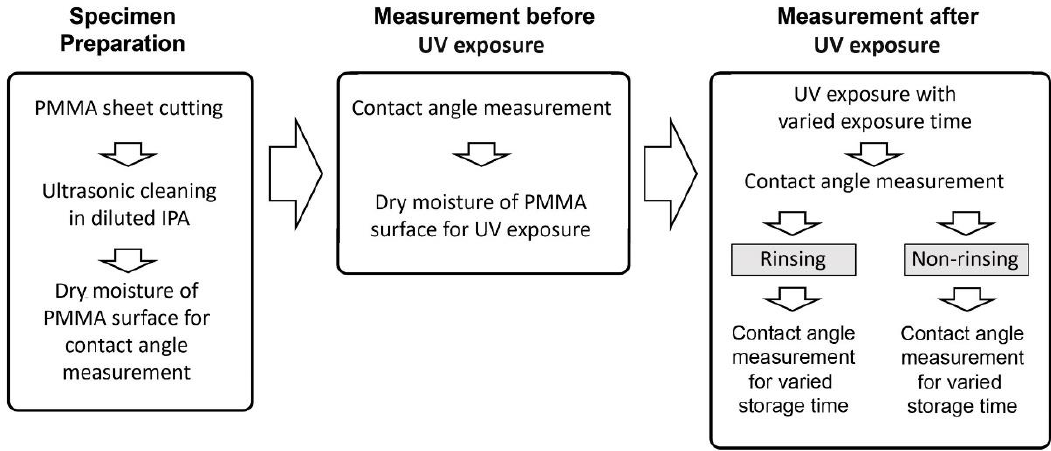
Figure 3. The Schematic Diagram of The Experimental Process.